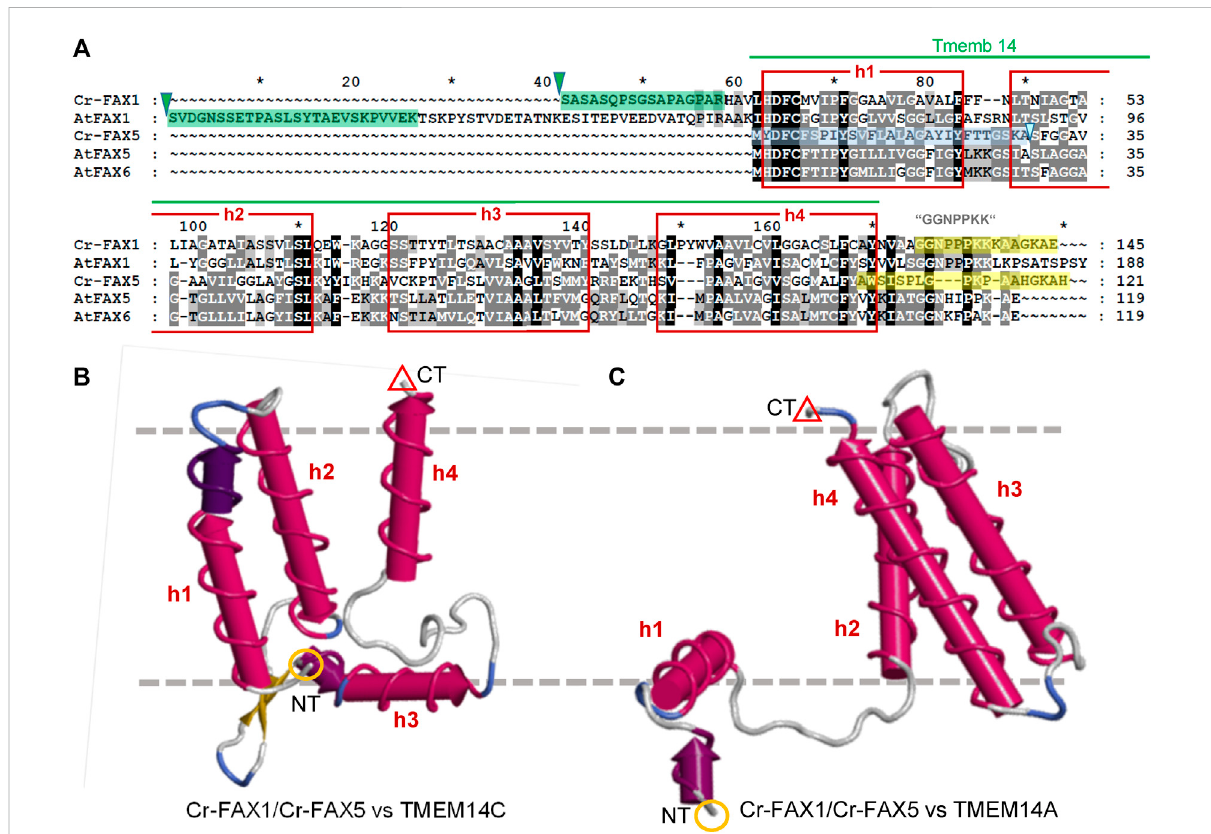
FIGURE 2 FAX1 and FAX5/6 proteins in Chlamydomonas and Arabidopsis. (A) Sequence alignment of mature FAX1 and FAX5/6 proteins in ChlamydomonasandArabidopsis. Thefour membrane-embedded α -helices(redboxes)within theTmemb_14 domain (pfam PF03647 motif,green line) are depicted according to the Aramemnon consensus prediction AramTmCon for At-FAX1 (Schwacke et al., 2003). Oligopeptides used to generate antisera against Cr-FAX1 and Cr-FAX5 are speci fi ed by yellow boxes. Processing sites for stromal peptidases according to TargetP2.0 (AlmagroArmenterosetal.,2019)areindicatedbygreentriangles,thepresumedERsignalpeptideforCr-FAX5isdepictedbyabluebox.ThemostN- terminalpeptidesofmatureCr-FAX1andAt-FAX1,identi fi edafterpeptidesequencingarehighlightedbygreenboxes.AmongtheFAX-proteinfamily inArabidopsis,Cr-FAX1showshighestsimilaritytoAt-FAX1(26%aaidentity)andCr-FAX5ismostlikelyrelatedtoAt-FAX5(32%identicalaas).Names, gene codes (AGI, Phytozome), and protein IDs (UniProt) are as follows: Cr-FAX1 (Cre10.g421750, A8ICM7), At-FAX1 (At3g57280, Q93V66), Cr-FAX5 (Cre08.g366000, A8J403), At-FAX5 (At1g50740, Q9C6T7), At-FAX6 (At3g20510, Q9LJU6). Note that our Cr-FAX1 and Cr-FAX5 correspond to CrFAX1andCrFAX2,describedin(Lietal.,2019),respectively. (B,C) StructuralmodellingofCr-FAX1andCr-FAX5(Phyre2;Kelleyetal.,2015)revealed high similarity to thestructure of human TMEM14C and TMEM14A proteins (con fi dence 99.7 – 99.9%). Depicted are 3D models of (B) Cr-FAX5 versus TMEM14C (PDB entry c2losA) and (C) versus TMEM14A (PDB entry c2lopA; right) generated by FirstGlance in Jmol ( fi rstglance.jmol.org). Note that modelsofCr-FAX1(notshown)arehighlysimilartothoseofCr-FAX5.Thefour α -helices(h1 – h4)oftheTmemb_14domainofFAX/TMEM14proteins are depicted as red cylinders. N- and C-terminal ends of the proteins are highlighted by orange circles (NT) and red triangles (CT). Boundaries of a lipid bilayer membrane are indicated by gray, dashed